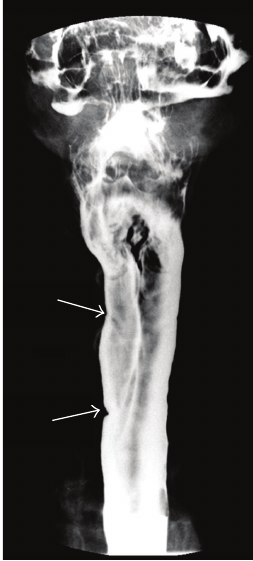
Figure 1: AP view of barium swallow showing two indentations (arrows) above the thoracic inlet and a slight lateral bulge of the esophageal lumen between the indentations.